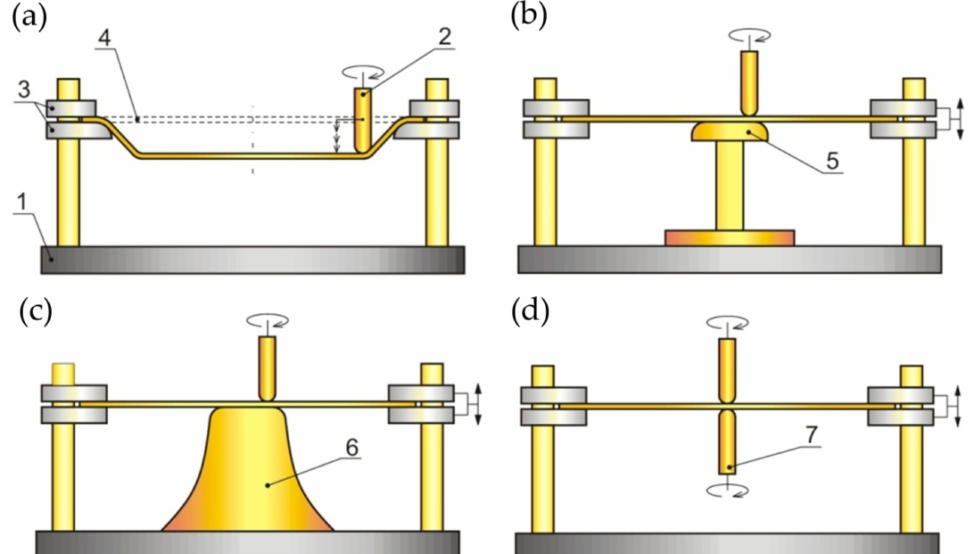
Figure 3. ISF Processes: ( a ) SPIF; ( b ) TPIF with a partial die; ( c ) TPIF a specific die; and ( d ) IFWCT: 1—clamping device, 2—forming tool, 3—plate holder, 4—workpiece (initial position), 5—partial die, 6—specific die and 7—auxiliary forming